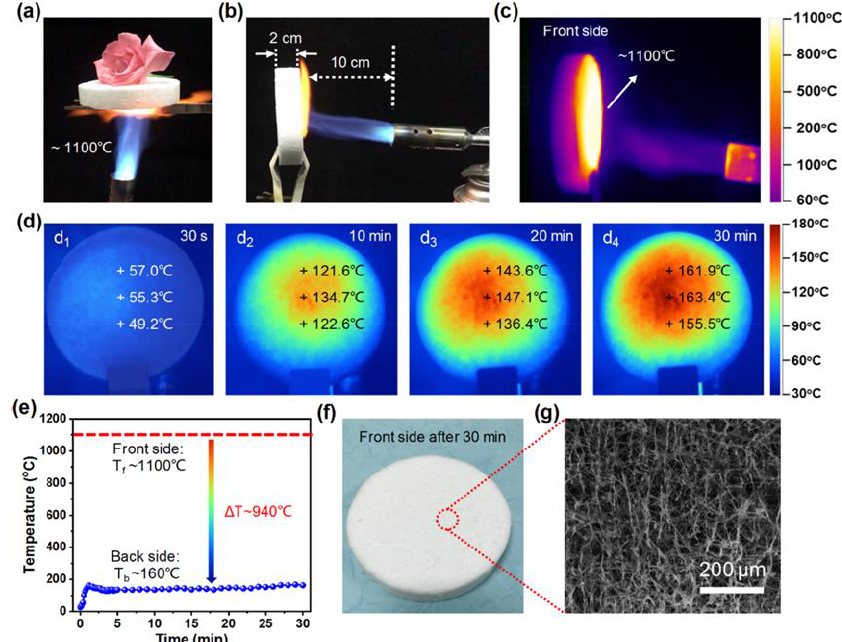
Figure 14. ( a ) Fresh flower protected by HNA3 with a thickness of 2 cm under the heating of a butane blowtorch for 10 min. ( b ) Illustration of the measurement setup using a butane blowtorch. ( c ) Infrared thermal image of the front side subjected to the butane blowtorch flame. ( d ) Infrared images of the back side during the 30 min heating process: (d1) 30 s, (d2) 10 min, (d3) 20 min, and (d4) 30 min. ( e ) The time-dependent temperature profile of the center point on the backside. ( f ) Photograph of the front side after 30 min fire resistance test. ( g ) SEM of the front side after 30 min fire resistance test (Reprinted with permission from Ref. [81]. 2019 American Chemical Society). Chemistry 2022 , 4 , FOR PEER REVIEW